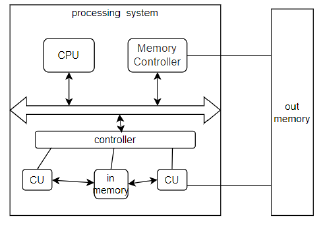
Fig 2. The top-level design framework of a heterogeneous Spark